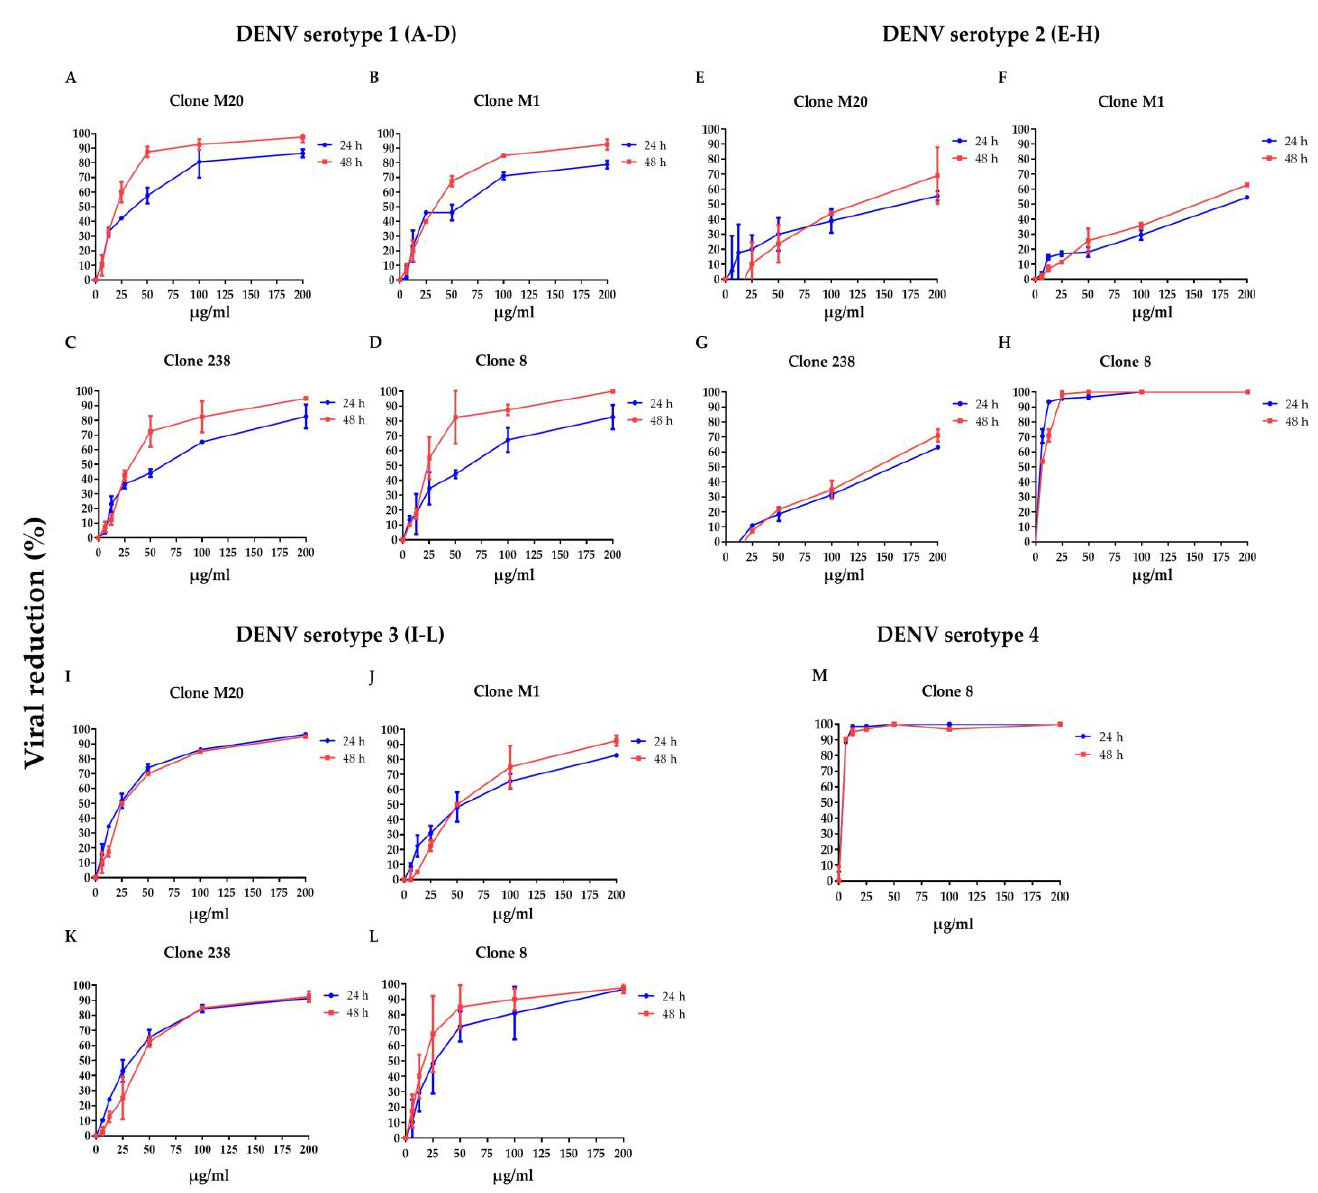
Figure 1. Anti-DENV NS1 HuMAbs induce DENV neutralization in endothelial cells: HMEC-1 were infected with four DENV serotypes (MOI = 0.125): ( A – D ) DENV 1, ( E – H ) DENV 2, ( I – L ) DENV 3, and ( M ) DENV 4 at 24 and 48 h post-infection. To determine the neutralization potency represented by the percentage of viral reduction in Vero cells, culture supernatant from four anti-DENV NS1 HuMAb (M20, M1, 238, 8)-treated infected cells are collected. The results are presented as the mean ± SD of duplicate independent experiments.